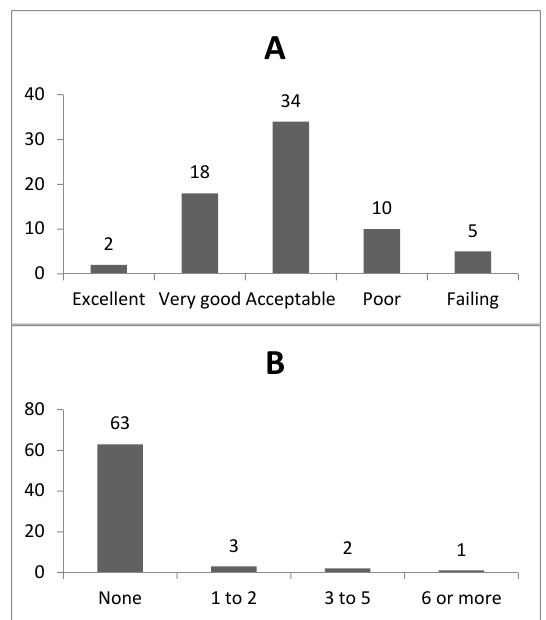
Figure 1. Absolute frequency of responses on the patient safety score (Panel A ) and absolute frequency of responses on the number of adverse events reported in the last 12 months (Panel B ) in the Psychosocial Care Network of the Municipality of Rio Branco, 2017 (n = 69).